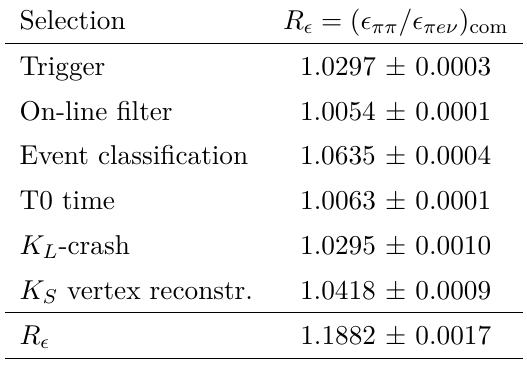
Table 5 . Ratios of MC efficiencies common to the K S → πeν and K S → π + π − selections with statistical uncertainties. The error on R is calculated as the quadratic sum of the errors of the (cid:15) single